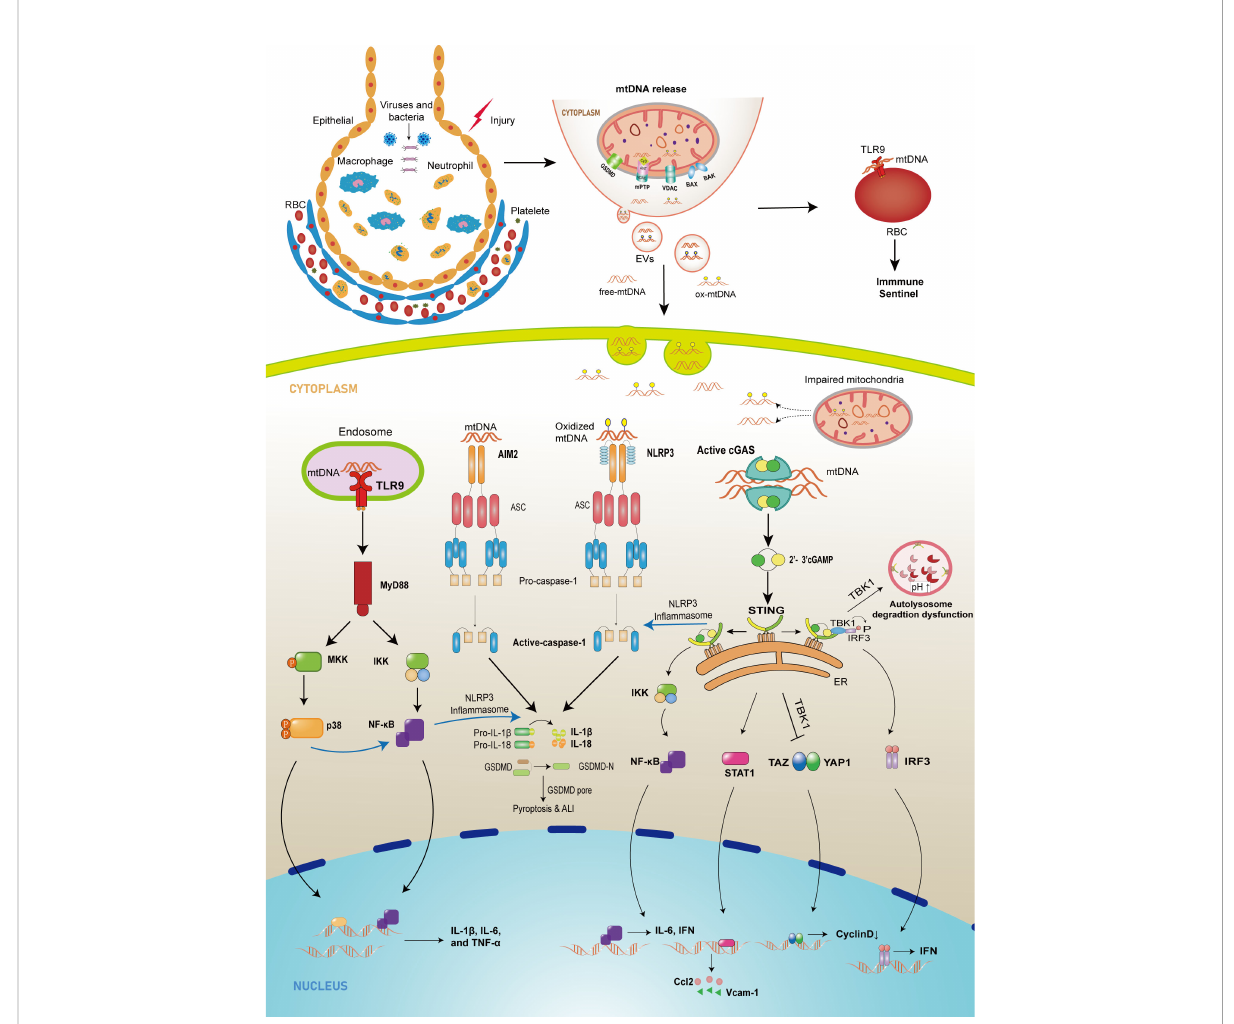
FIGURE 1 The schematic diagram of mtDNA-releasing and sensing pathways mediating injury in lung tissue. In cell injury or infection conditions, abnormal mtDNA can be released from mitochondria into cytosol through mPTP, GSDMD pore, MOMP mediated by BAX/BAK and VDAC, or from cytosol to extracellular environment by EVs. Once in the cytosol, mtDNA, which comes from intracellular injured mitochondria or extracellular space, can be recognized by three major sensors that drive the innate immune response. First, the released mtDNA can bind to TLR9 on the surface of erythrocytes to induce an immune response or bind to TLR9 in the endosome, which promotes the expression of downstream NF- k B or p38 MAPK, leading to an upregulation of pro-in fl ammatory factor expression. Cytoplasmic mtDNA is also recognized by cGAS and leads to increased expression of cytokines, adhesion molecules, and chemokines through different pathways and can inhibit autophagy and endothelial cell proliferation. In addition, the released mtDNA activates PRRs such as NLRP3 and AIM2, recruiting ASC and procaspase-1 to form in fl ammasomes and promoting IL-1 b and IL-18 maturation and